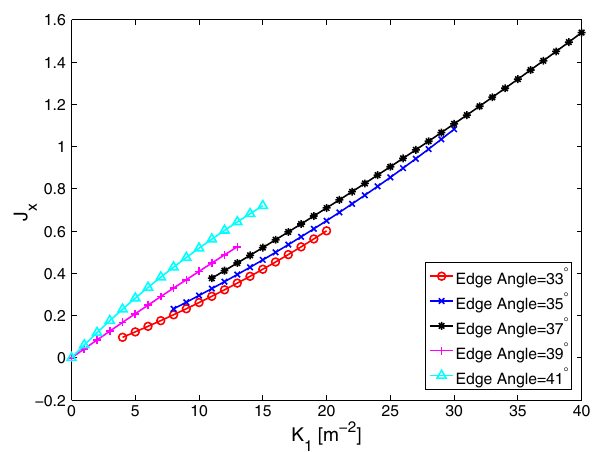
FIG. 3. Horizontal damping partition number J focusing strengths and various edge angles of the dipole magnets. The focusing strengths of quadrupoles K 1 vary within the stable condition.